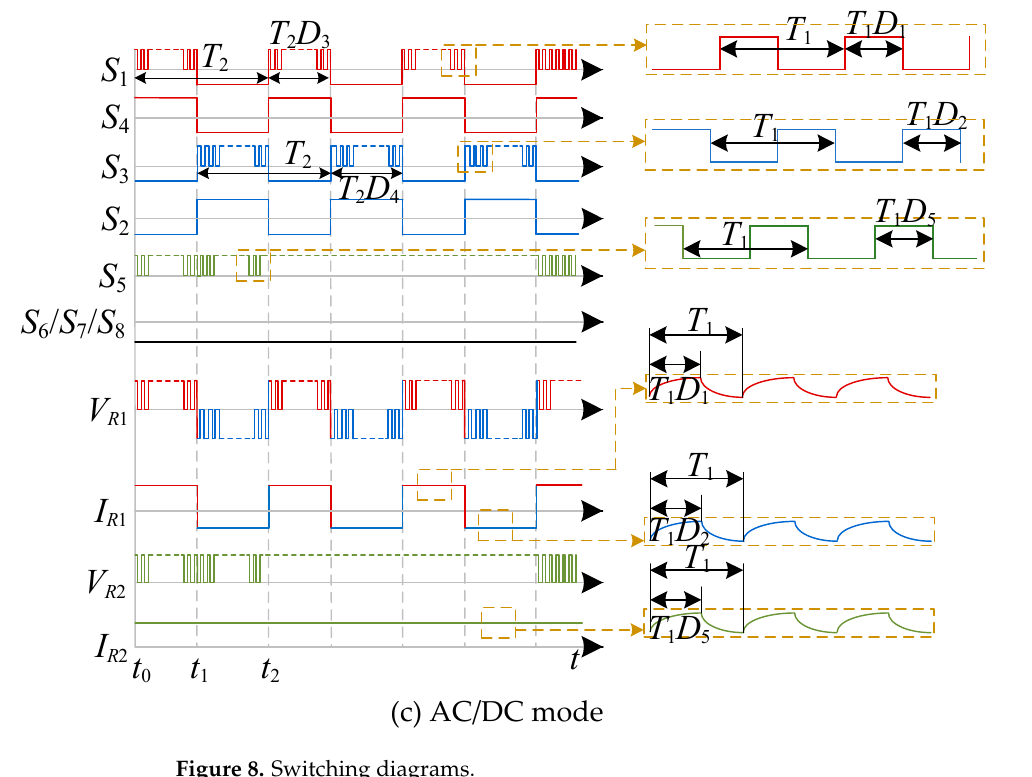
Figure 8. Switching diagrams.